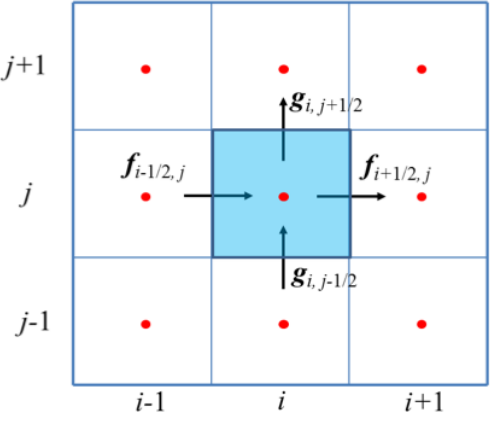
Figure 2. Two-dimensional finite-volume